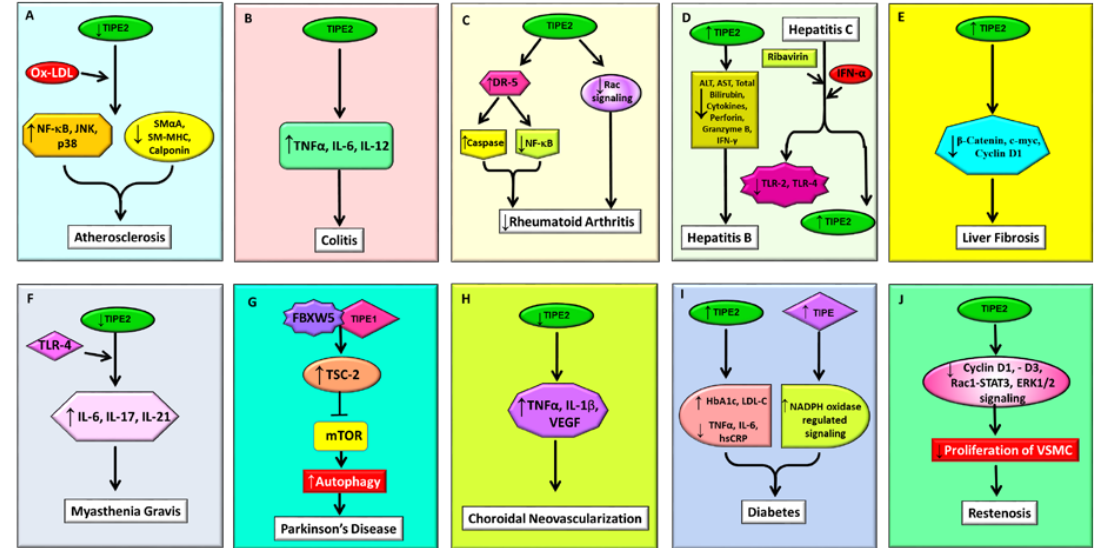
Figure 2. Role of TIPE family of proteins and their molecular mechanisms in different chronic diseases; ( A ). Atherosclerosis, ( B ). Colitis, ( C ). Rheumatoid Arthritis, ( D ). Hepatitis B and C, ( E ). Liver Fibrosis, ( F ). Myasthenia Gravis, ( G ). Parkinson’s Disease, ( H ). Choroidal Neovascularization, ( I ). Diabetes, ( J ). Restenosis.